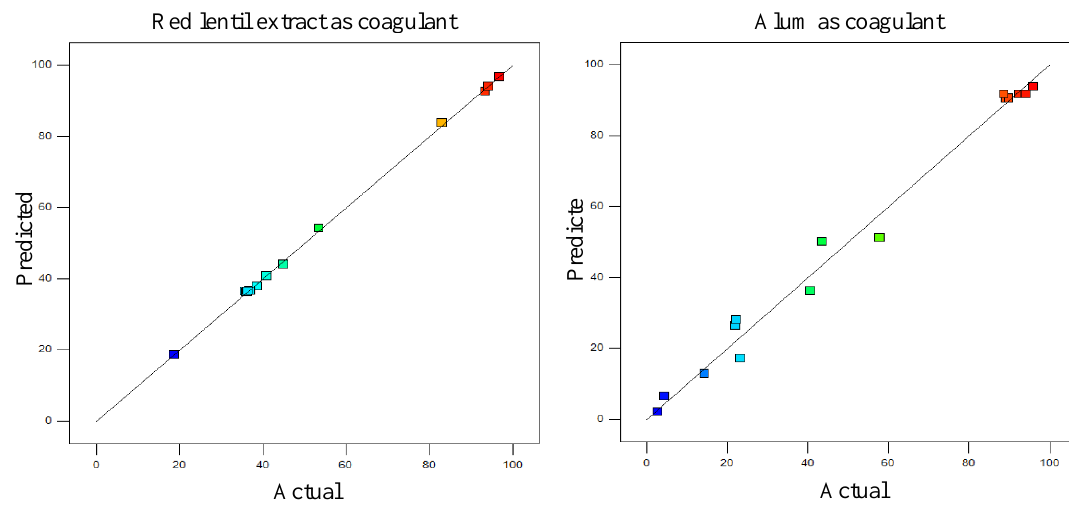
Figure 4. Diagnostic plots: Predicted vs. actual plot for turbidity reduction (red = high turbidity removal, green = medium turbidity reduction and blue = low turbidity reduction).